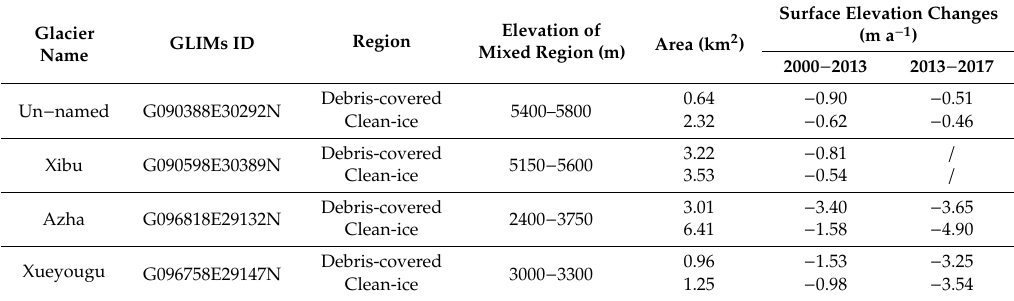
Table 7. The surface elevation changes of the four debris-covered glaciers. Note: the area was a mixture of debris-covered and clean-ice portions; the surface elevation change of the Xibu glacier in 2013–2017 was not retrieved since cloud cover in the 2017 ZY-3 stereo images.